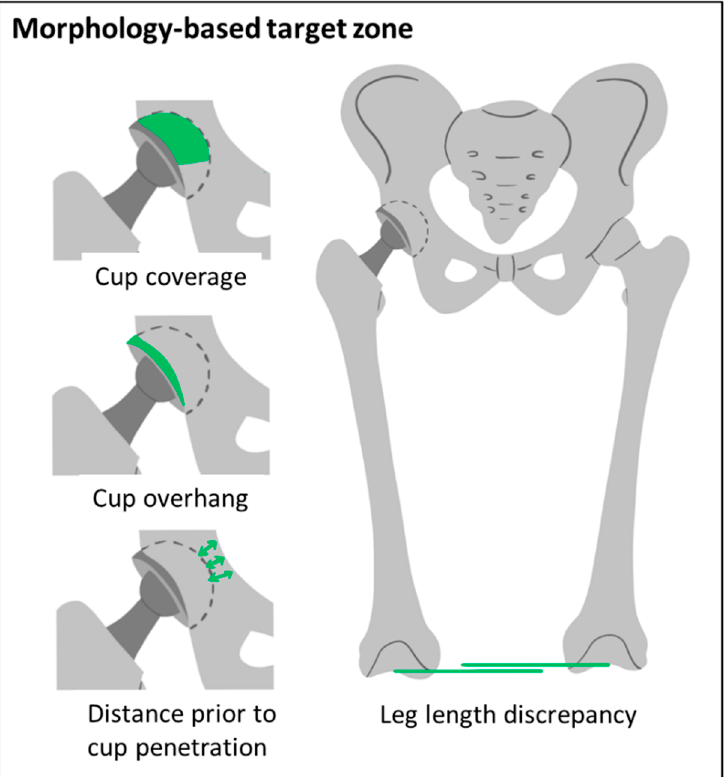
Figure 2. Criteria considered for the morphology-based target zone.